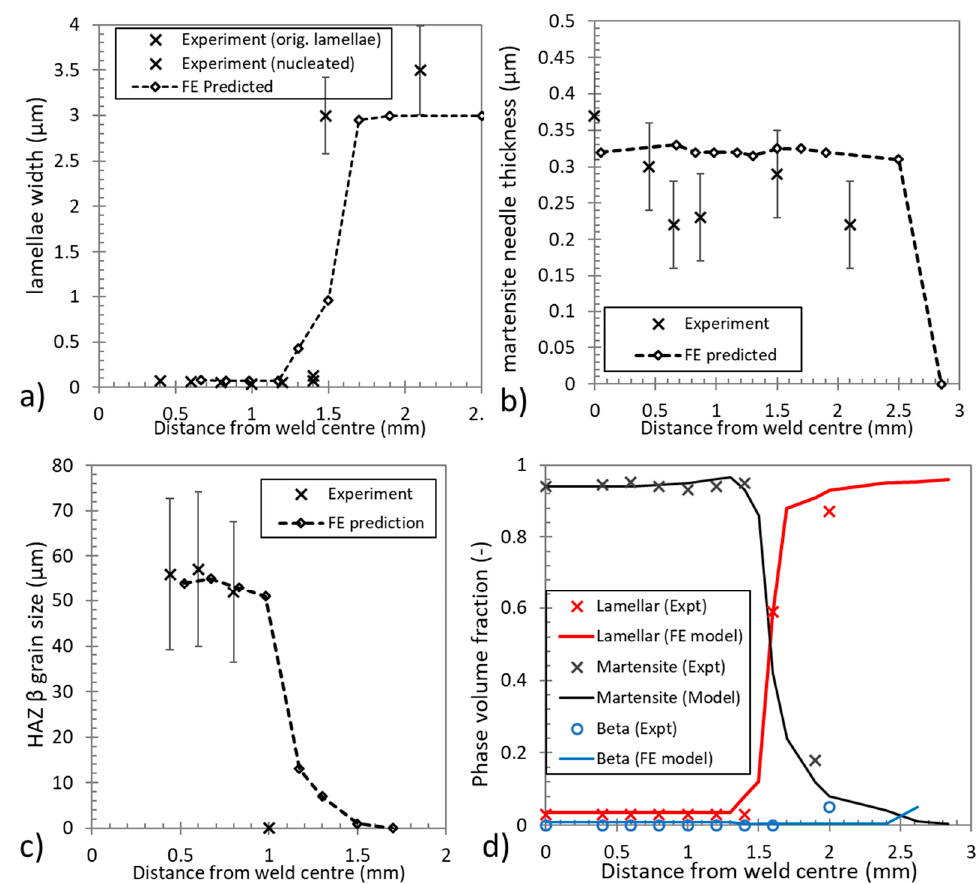
Figure 14. FE–metallurgy coupled model predictions from weld d: ( a ) α radius; ( b ) martensite needle thickness; ( c ) β grain size in the HAZ; ( d ) volume fractions of each